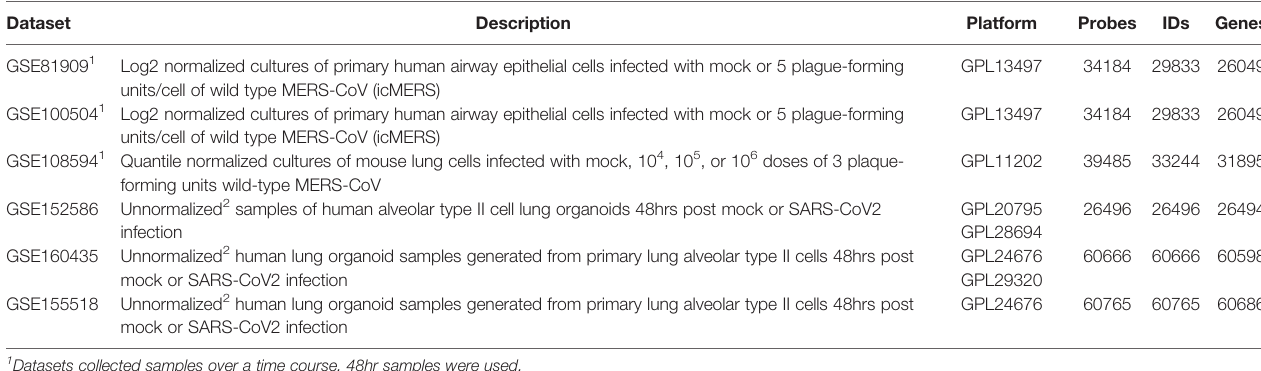
TABLE 2 | MERS-CoV and SARS-CoV2 Infection Datasets Utilized for this Study.